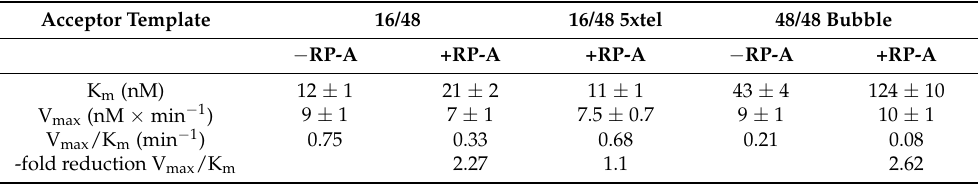
Table 1. Effect of RP-A on the kinetic parameters for template binding by DNA polymerase λ during MMST DNA